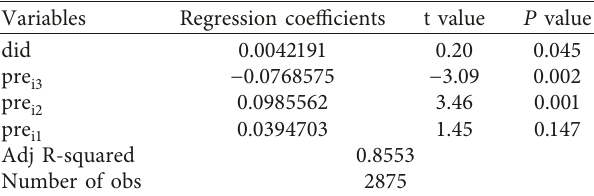
Table 4: Dynamic effect regression